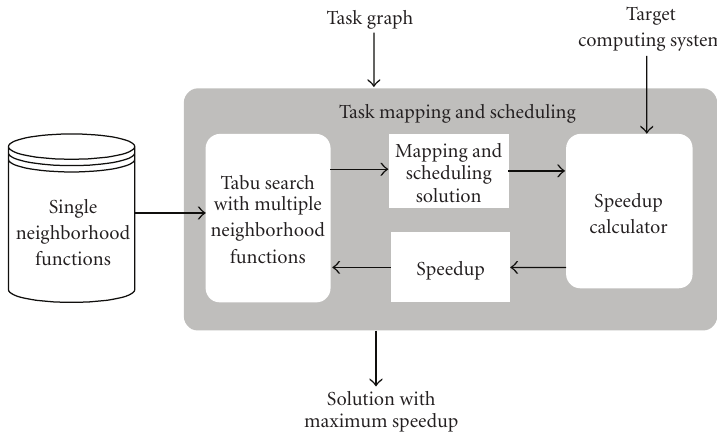
Figure 6: Overview of the mapping and scheduling